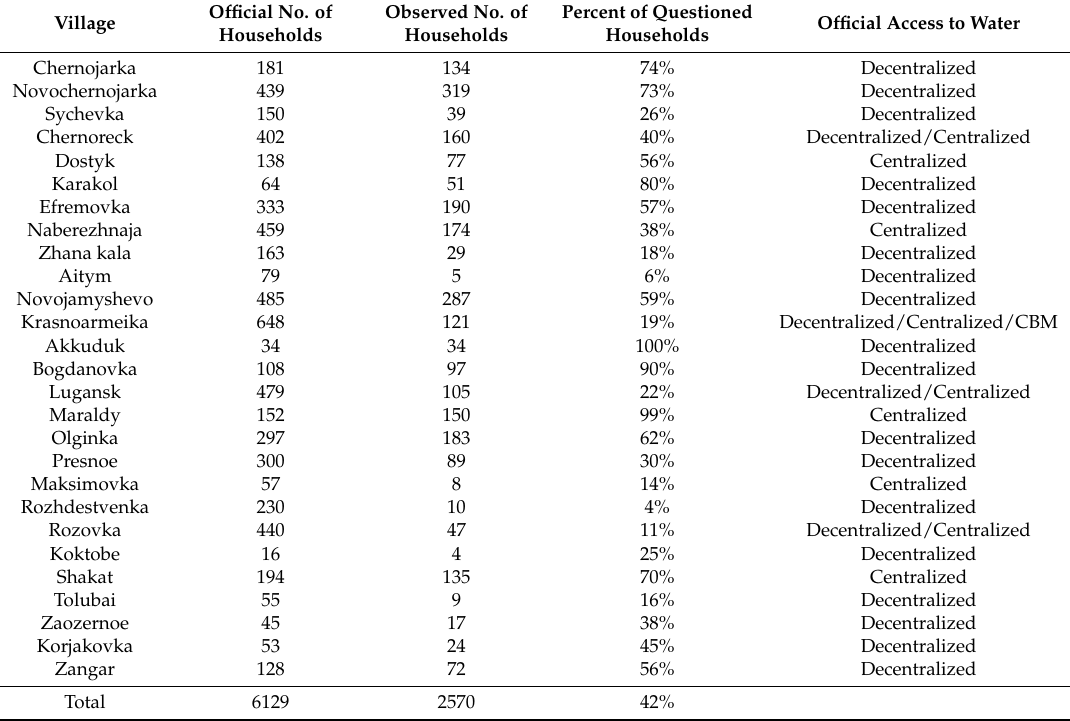
Table A1. Collected samples from each